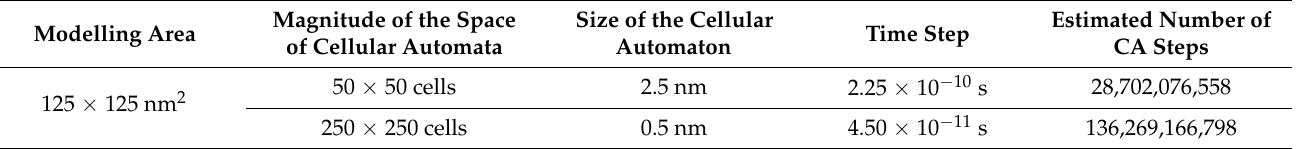
Figure 8. DMR images with the zinc redistribution maps after simulation of DP transformation with migrating RFs at constant velocity v = 10 nm/s at 400 K (~127 ◦ C), after 9 and 12 s, for different cases of CA space discretisation with sizes: 50 × 50 cells with L CA = 2.5 nm ( a , c ); 250 × 250 cells with L CA = 0.5 nm ( b , d ). Table 1. Summary of results informing computational complexity of the CA model, depending on the discretisation density of the modelling area, after simulations of the DP transformation under RF migration conditions with constant velocity v = 10 nm/s at 400 K (~127 ◦